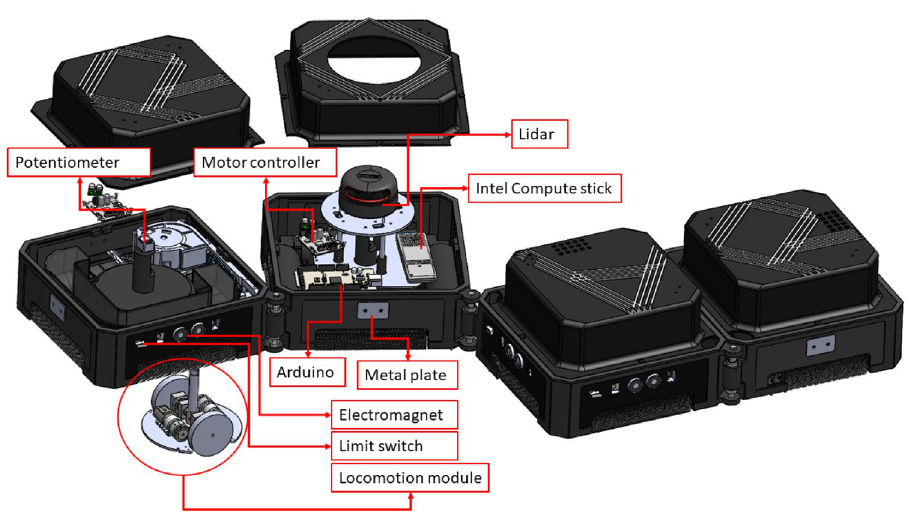
Figure 4. hTetro hardware